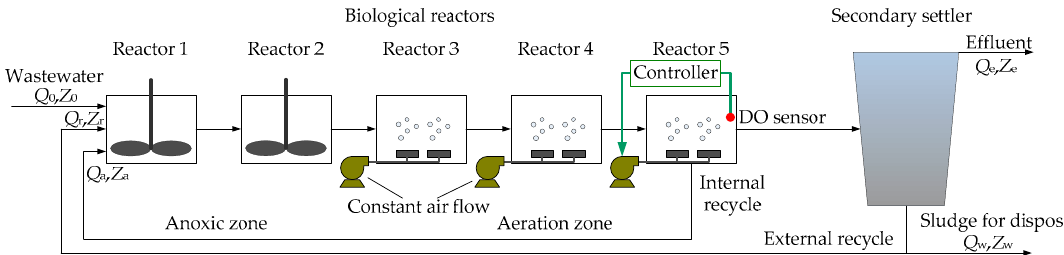
Figure 2. Schematic representation of Benchmark Simulation Model No. 1 (BSM1) model.